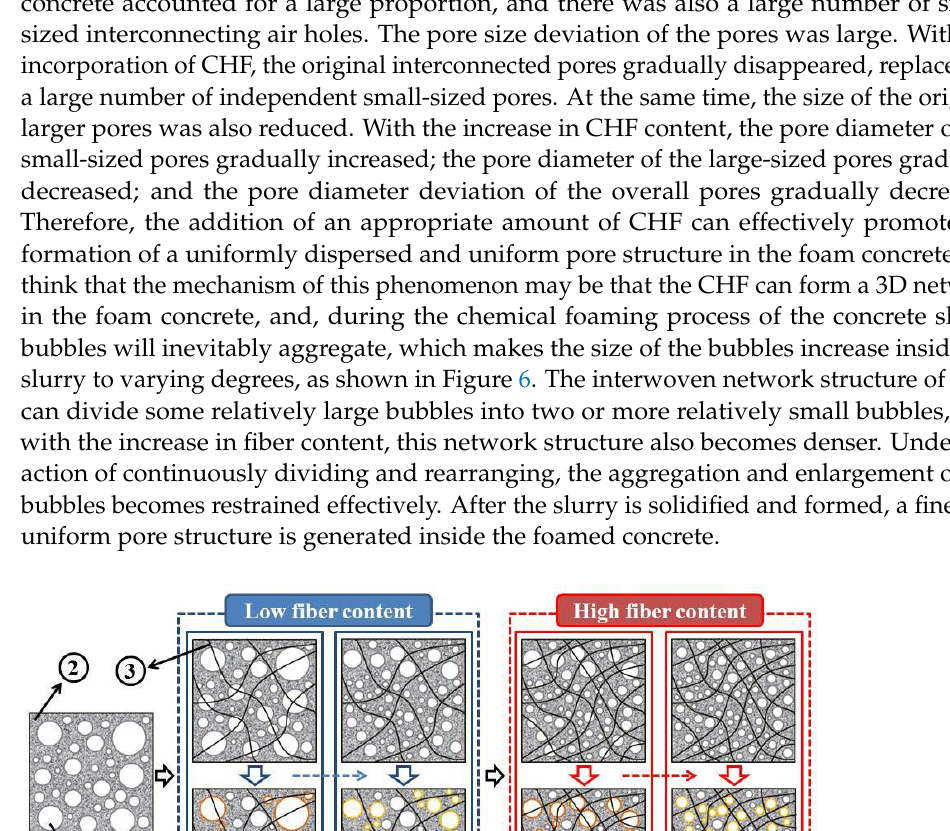
Figure 5. The pore structure of CHF foam fiber after binarization using IPP software.